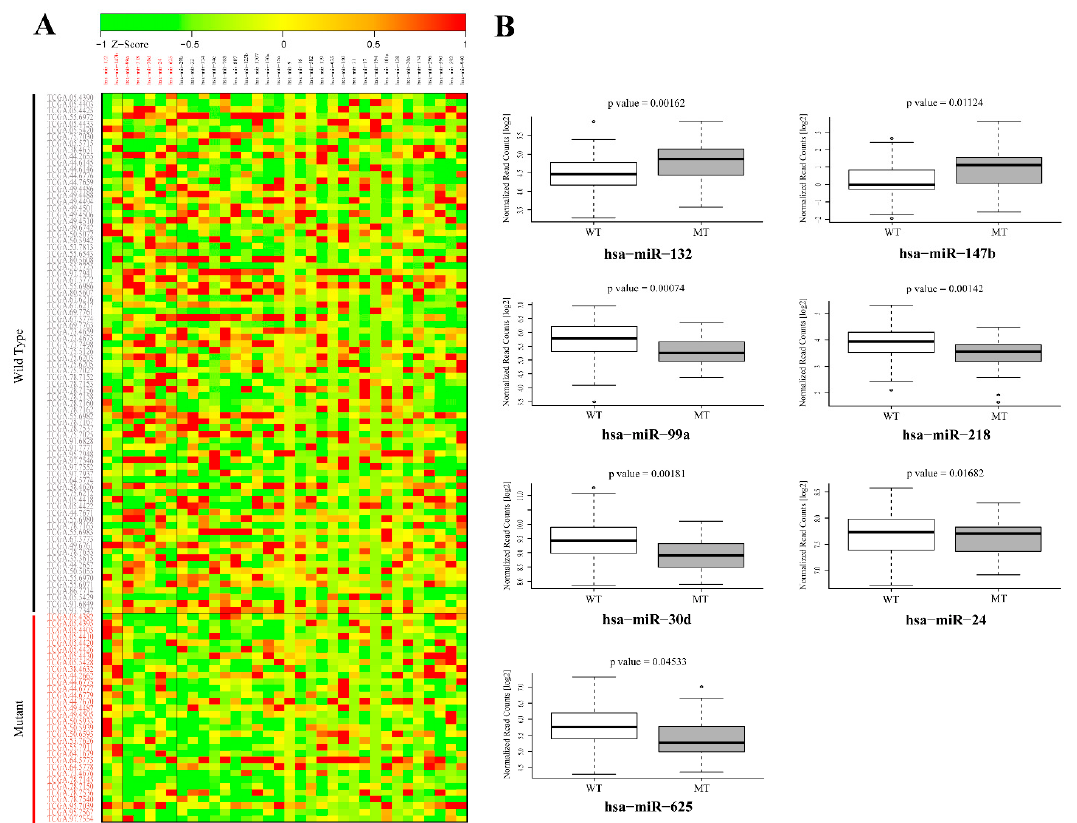
Figure 4. Validation of mutant p53 R273H -regulated miRNAs in the TCGA lung adenocarcinoma patient dataset. ( A ) Heat map showing normalized read counts of mutant p53 R273H -regulated miRNAs across TCGA lung adenocarcinoma patients bearing wild type and mutant p53. Based on TP53 mutation status, TCGA patients were categorized into two groups, wild type and mutant p53 patients. The relative expression levels of mutant p53-regulated miRNAs obtained in the present study were subsequently validated by comparing their normalized read counts between these two groups of patients. Patients with wild type p53 and mutant p53 are shown in black and red color letters respectively. miRNAs shown in red are significantly ( p < 0.05) altered between wild-type and mutant p53 patients with a pattern similar to that of our small RNA sequencing results. Heat map scale bar indicates Z-scores of normalized read count values. ( B ) Box-Whisker plots showing log2 transformed normalized read counts of two up-regulated and five down-regulated miRNAs in patients with mutant p53. p -values are indicated.